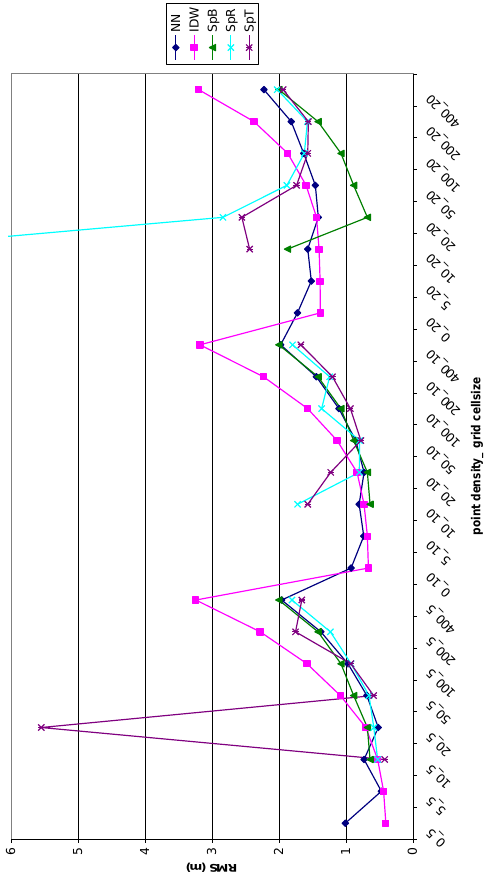
Figure 2. Bardonecchia site, quality assessment (NN = Natural Neighbors, IDW = Inverse Distance Weighing, SpB = Tension Spline with Barriers, SpR = Regularized Spline, SpT = Tension